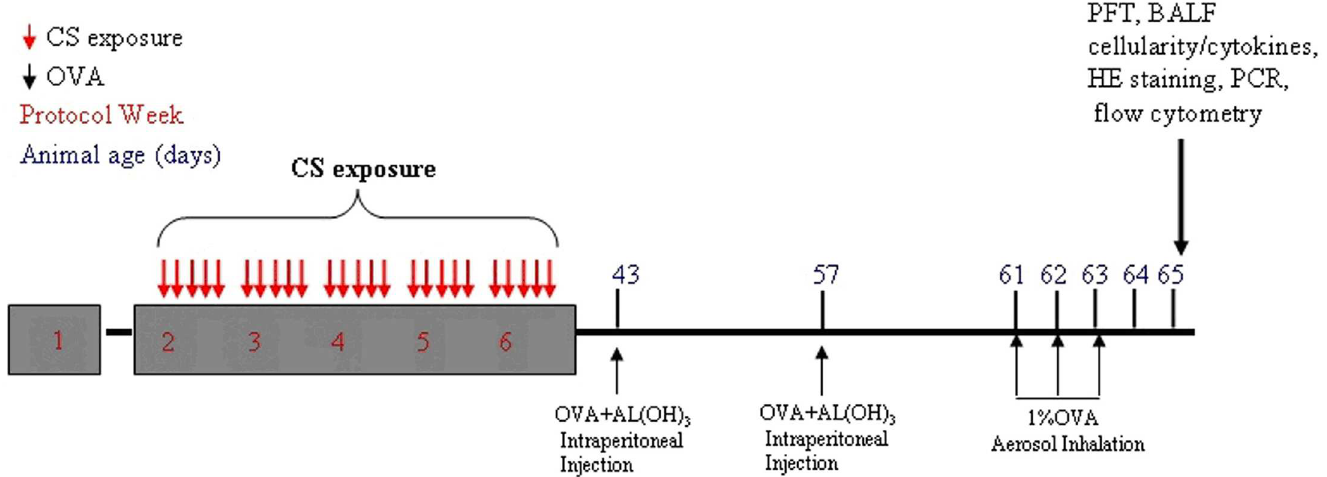
Fig 1. Schematic of the mouse model of early-life expose to CS and OVA sensitization. The processes of CS exposureand OVA sensitization in BALB/c mice are illustrated. The numberin grey box indicatesthe numberof weeks post-delivery. The numbers abovethe line indicatethe time in postnataldays. The arrow represents the time of each treatment. The treatment method and time are describedabove or belowthe arrow.